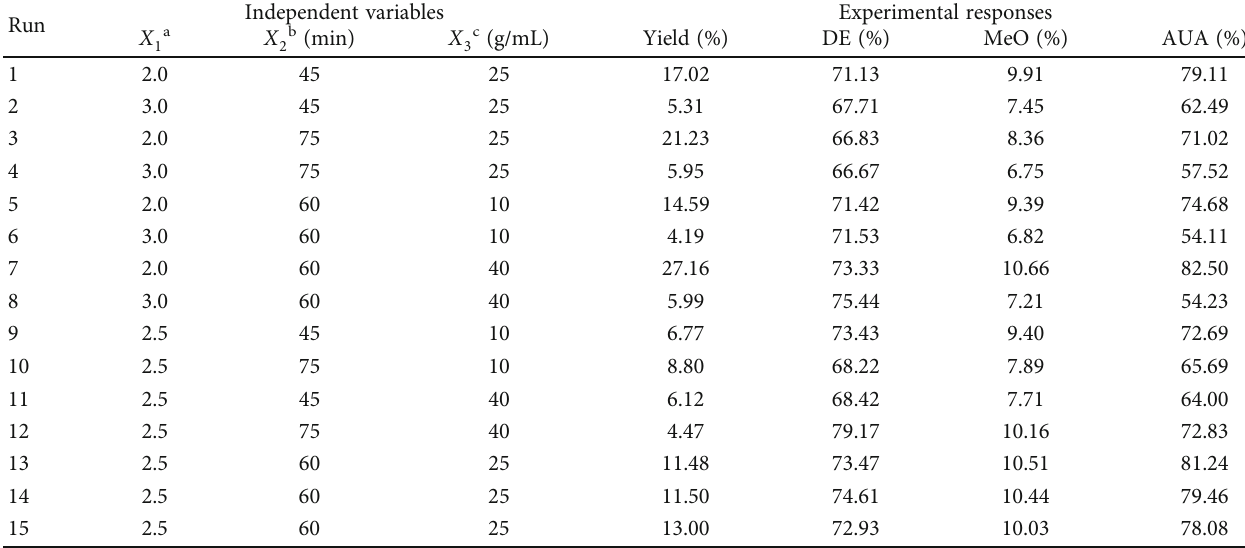
Table 2: Experimental conditions of pectin extraction with citric acid and responses for the Box-Behnken experimental design. Independent variables Experimental responses Run X